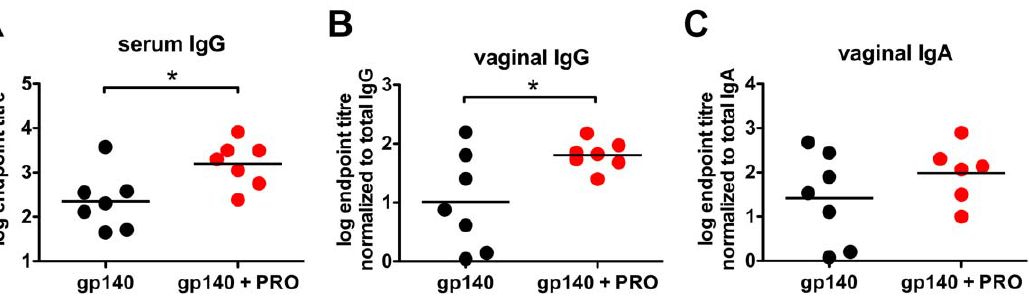
Figure 3. Second-site immunization in the presence of PRO 2000 increases systemic and mucosal antibody responses. BALB/c mice (n=7) were primed intranasally with 10 m g gp140 per animal in polycation and were boosted three times vaginally with gp140 + / 2 PRO 2000. Samples were collected 14 days after the final vaginal immunization. Serum IgG endpoint titres ( A ), or vaginal lavage IgG ( B ) and IgA ( C ) endpoint titres normalized to the total IgG or IgA content or each sample, respectively, are displayed. gp140 + PRO , combination of gp140 and PRO 2000.